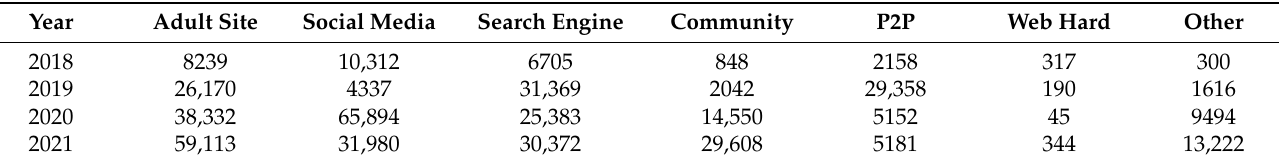
Table 6. Deletion support by